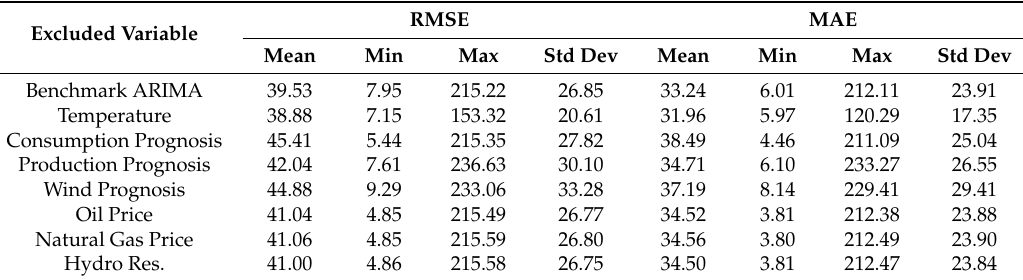
Table 4. ARIMA with seven regressors.